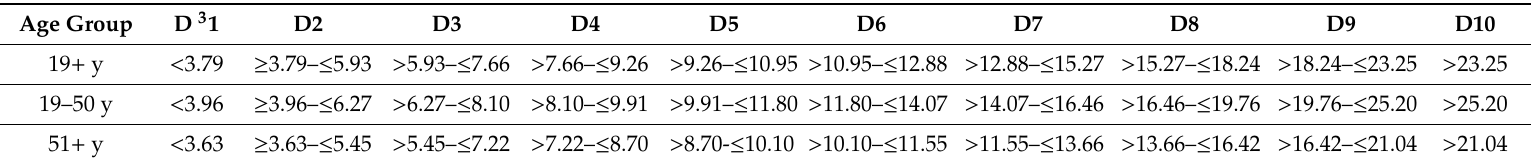
Table 1. Deciles of two-day average intake of added sugars (% of calories) 1,2 in adults 19 + y (National Health and Nutrition Examination Survey (NHANES)